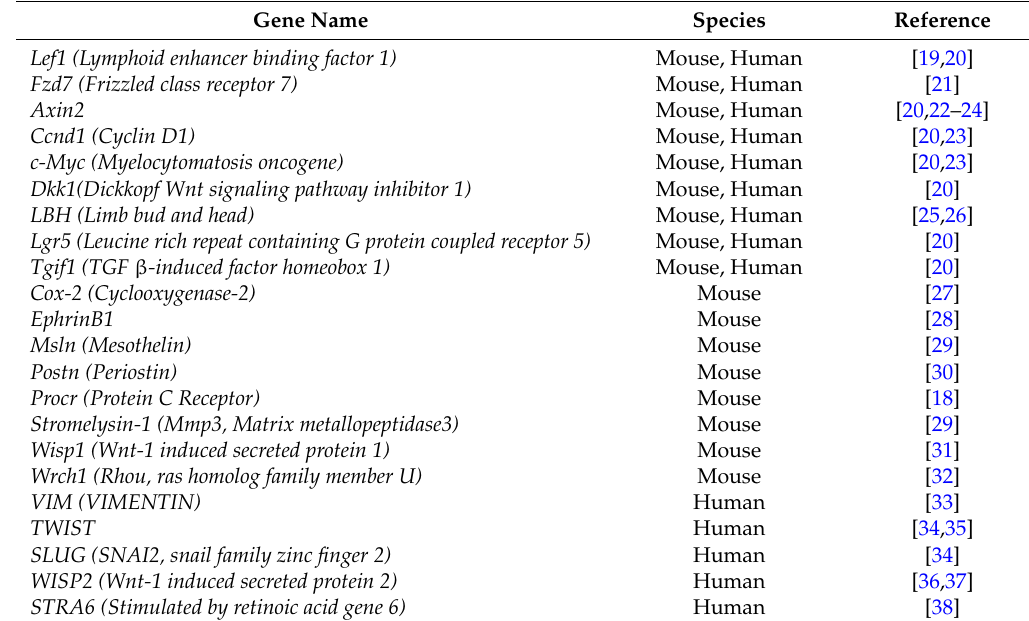
Table 1. Wnt target genes in the mammary